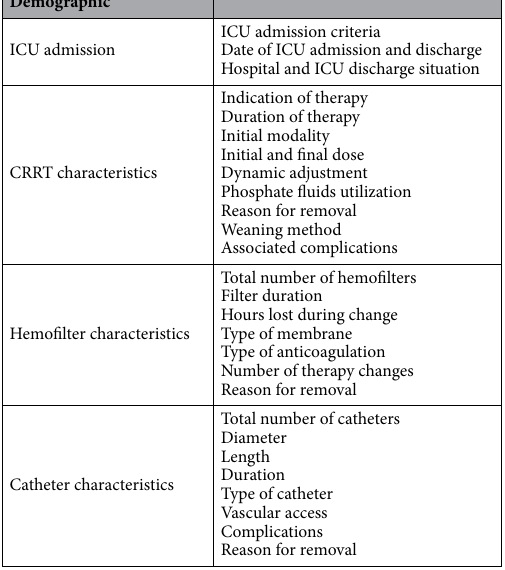
Table 1. Collected variables from DIALYREG